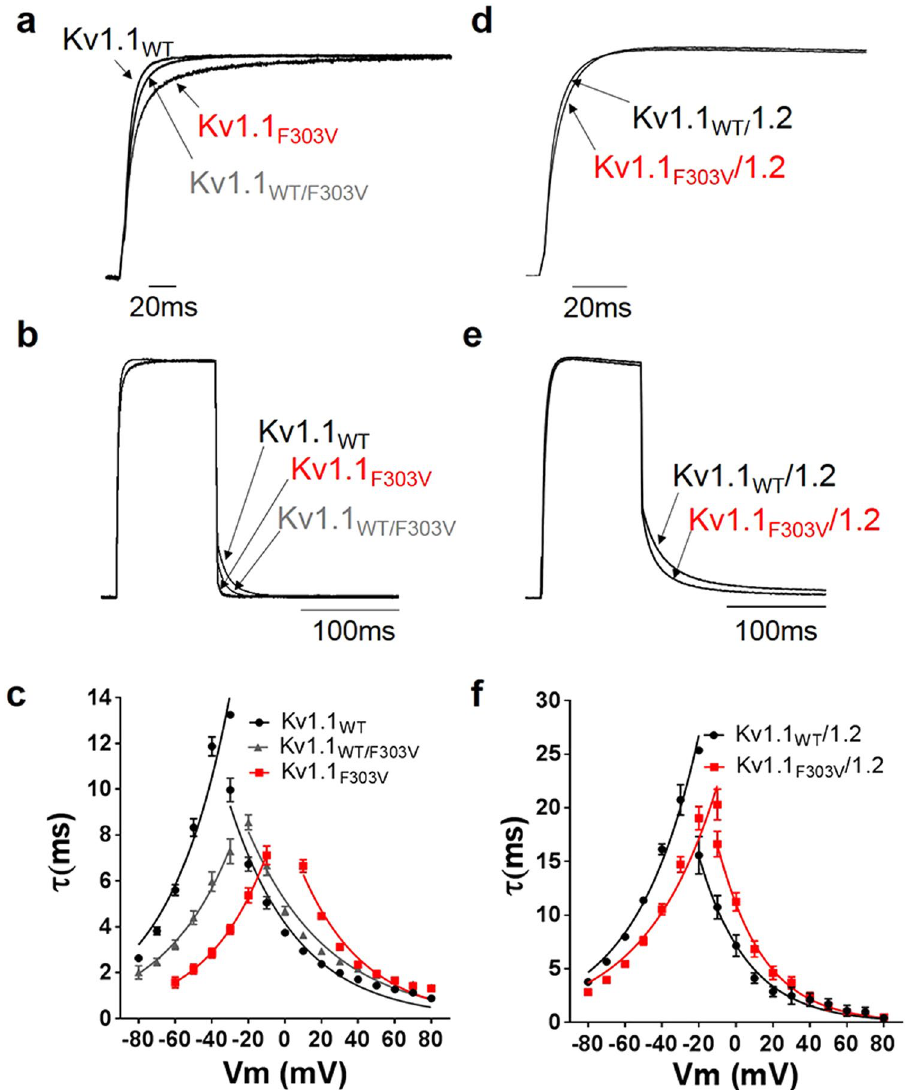
Figure 5. Effect of mutation on channel activation and deactivation kinetics. Activation kinetics were derived from the rising phase of currents evoked by depolarizing pulses ( − 20 to + 80 mV), lasting 300 ms from a holding potential of − 80 mV. Deactivation kinetics were derived from tail currents recorded at potentials − 20 to − 80 mV (pre-pulse potential + 20 mV). Normalized and superimposed representative Kv1.1 ( a ) and Kv1.1/1.2 ( d ) activating currents were recorded at + 20 mV, and Kv1.1 ( b ) and Kv1.1/1.2 ( e ) deactivating currents recorded at − 50 mV. Activating and deactivating current traces were fitted with double and single exponential functions, respectively. Time constants of the currents were plotted as a function of membrane potential for Kv1.1 ( c ) and Kv1.1/1.2 ( f ) channels. Plots show that mutation results in slower activation but faster deactivation. The data points are mean ± SE of 8